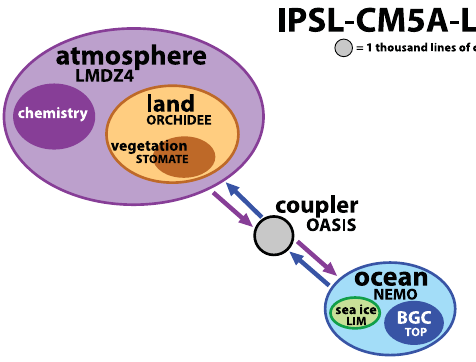
Figure 7. Architecture diagram for MPI-ESM-LR.